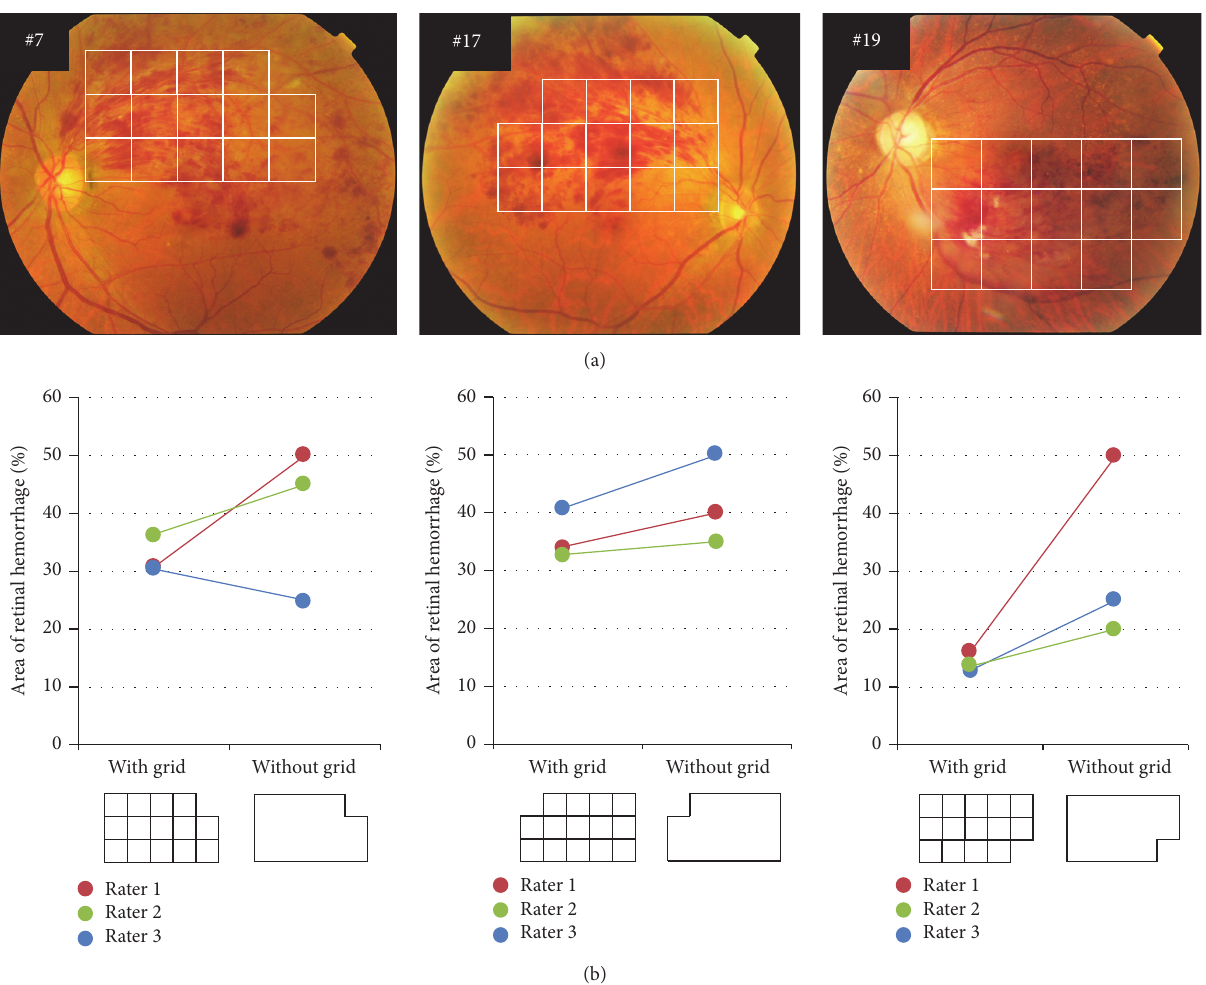
Figure 2: Three representative fundus photographs of eyes with a BRVO, and the results of the retinal hemorrhage sizes measured by using the grid with 14 squares and an empty box with no grid. (a) shows three fundus photographs of eyes #7, #17, and #19 that are overlaid with the grid to measure the size of the retinal hemorrhages. (b) is a graph plotting the retinal hemorrhage size measured with the 14-square grid and with the empty box made by the three raters. Note that there is less variation between three raters when they used a grid with 14 squares than when they used the empty box.